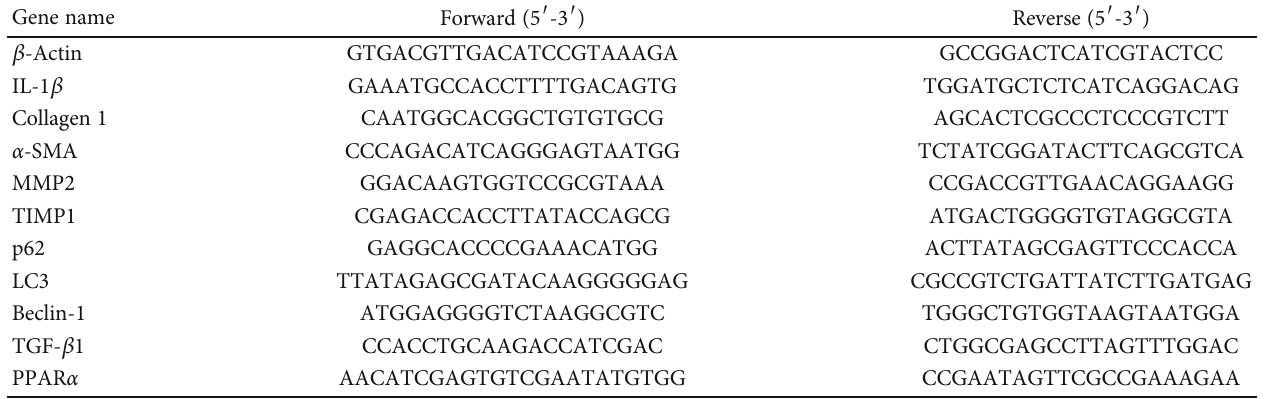
Table 2: Oligonucleotide sequences of primers used for